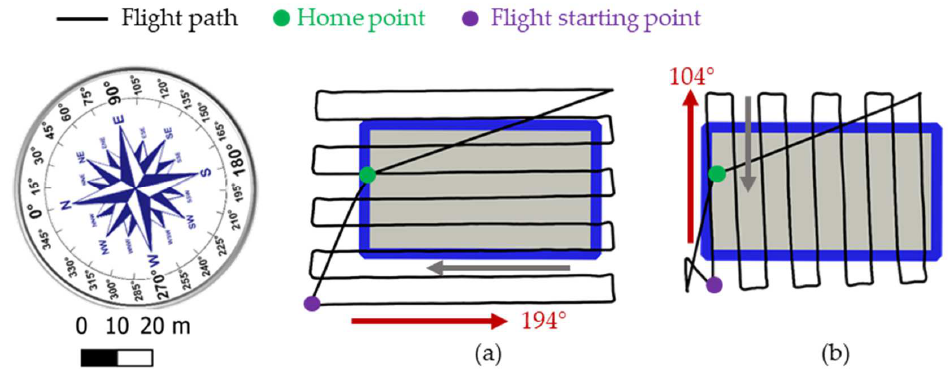
Figure 18. Flight path orientations used; ( a ) 194° direction for f1 reference flight; ( b ) 104° direction for flights f4 and f5. Flight f5 was like f4 but at 40 m AGL.